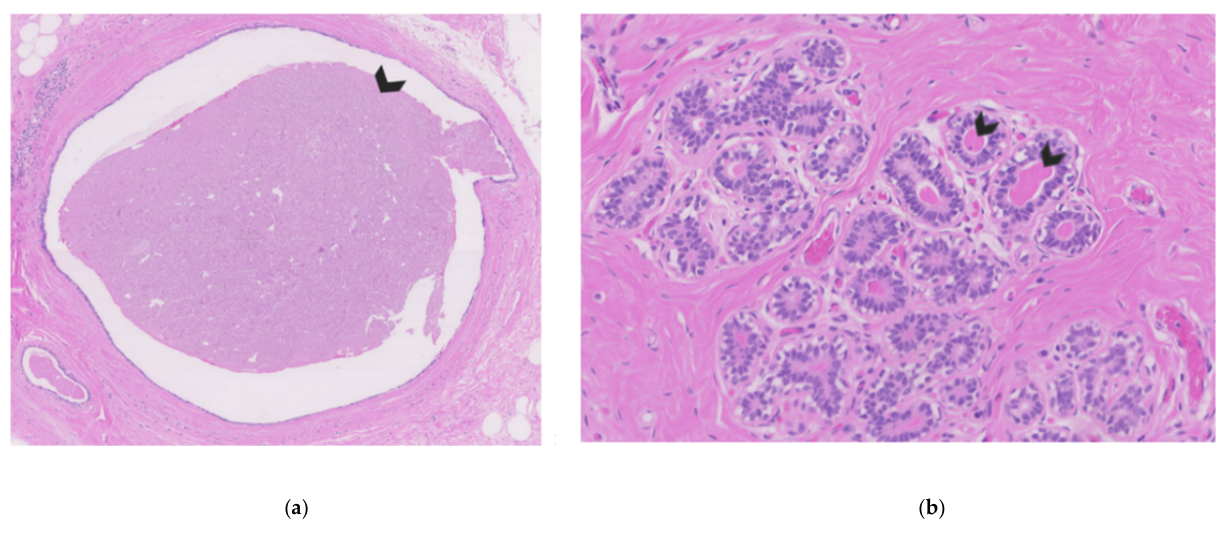
Figure 1. Breast tissue of a non-lactating breast. ( a ) Cross-section of breast ducts filled with nipple fluid on the inside (see arrow). ( b ) Cross-section of breast lobules with acini filled with eosinophilic nipple fluid on the inside (arrows indicate two examples).